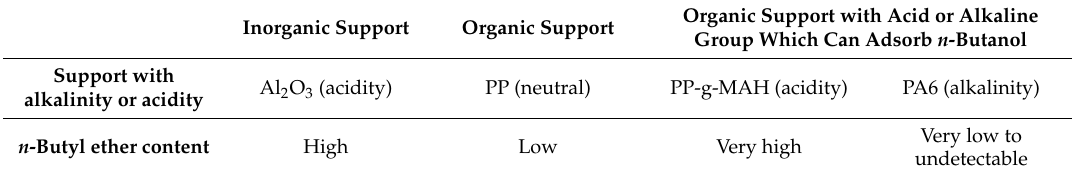
Figure 2. Schematic representation of elimination of n -butyl ether over Raney Ni/PA catalyst. Table 2. The relationship between the property of catalyst support and the byproduct content [19]. Reproduced from Ref. [19] with permission from the Royal Society of Chemistry.